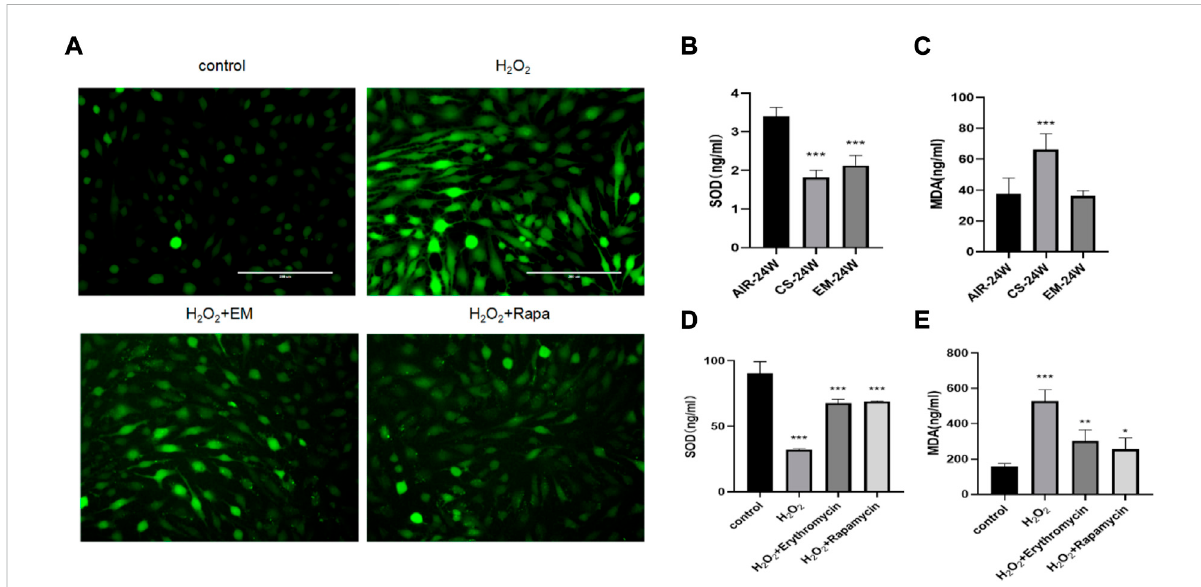
FIGURE 3 Antioxidant effect of erythromycin in vivo and in vitro . (A) Fluorescence photomicrographs of different groups of BEAS-2B cells. BEAS-2B cells were treated with 100 μ M H 2 0 2 ,10 mg/m1 erythromycin or lOnM rapamycin. (B – C) SOD and MDA levels in mice. (D – E) SOD and MDA levels